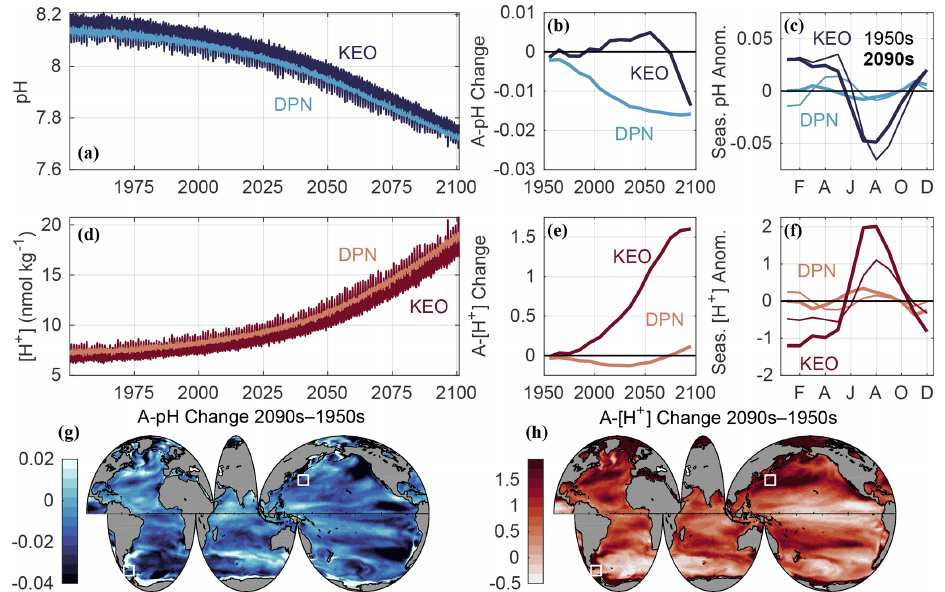
Figure 3. Data used in this figure come from the GFDL ESM2M model for the combined historical and RCP8.5 experiments. Time series of surface ocean (a) pH and (d) [H + ] (nmolkg − 1 ) at model grid points corresponding to the Kuroshio Extension Observatory (KEO) and the Drake Passage region north of the Antarctic Polar Front (DPN), similar to Region 1 in Munro et al. (2015). Surface ocean seasonal cycle amplitudes ( A ) were averaged for each decade and smoothed with a running mean filter using a four-element sliding window. Shown are the decadal changes in (b) A -pH and (e) A -[H + ] (nmolkg − 1 ) relative to the 1950s, as well as the surface ocean (c) pH and (f) [H + ] (nmolkg − 1 ) monthly anomalies relative to the annual mean at KEO and DPN during the 1950s (thin lines) and 2090s (thick lines). Global maps show the total change in (g) A -pH and (h) A -[H + ] (nmolkg − 1 ) between the 1950s and 2090s. White boxes are centered at the KEO and DPN time-series sites. Simulated 1950s and 2090s annual mean pH and [H + ] values, as well as the 2090s minus 1950s change in A -pH and A -[H + ], at these locations are listed in Table S2. A total of 45 additional time-series locations are included in Table S2 and Fig.